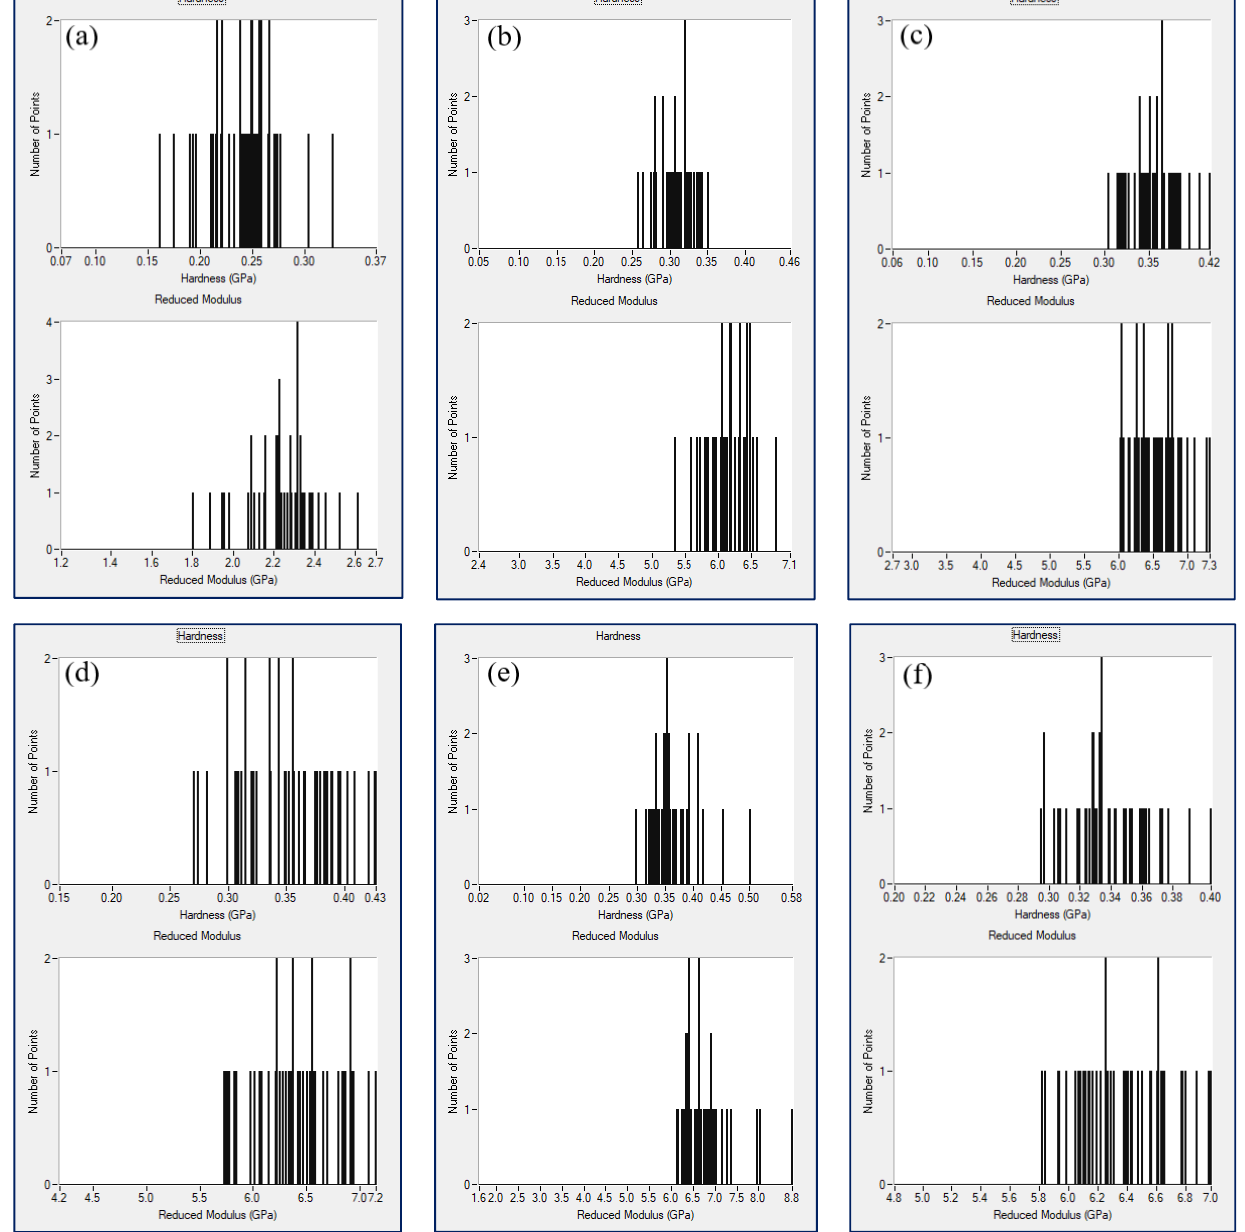
Figure 4. XPM histogram graphics of pure PLA ( a ), 6 wt%GNP/PLA ( b ), 6 wt%MWCNT/PLA ( c ), 4.5 wt%GNP1.5 wt%MWCNT/PLA ( d ), 3 wt%GNP3 wt%MWCNT/PLA ( e ) and 1.5 wt%GNP4.5 wt%MWCNT/PLA ( f ).